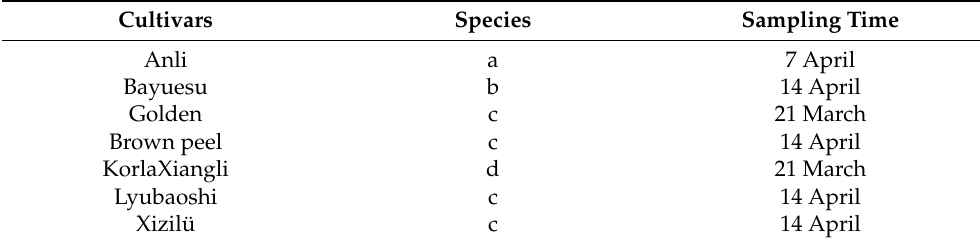
Table 1. The species of seven pear cultivars and sample collection date. Cultivars Species Anli